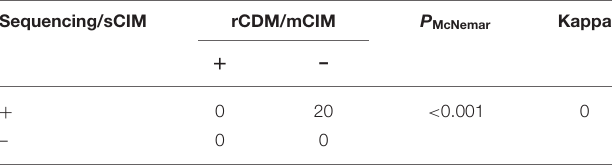
TABLE 9 | The statistic results of sequencing/sCIM and rCDM/mCIM for 20 A. baumannii isolates. Sequencing/sCIM rCDM/mCIM P McNemar